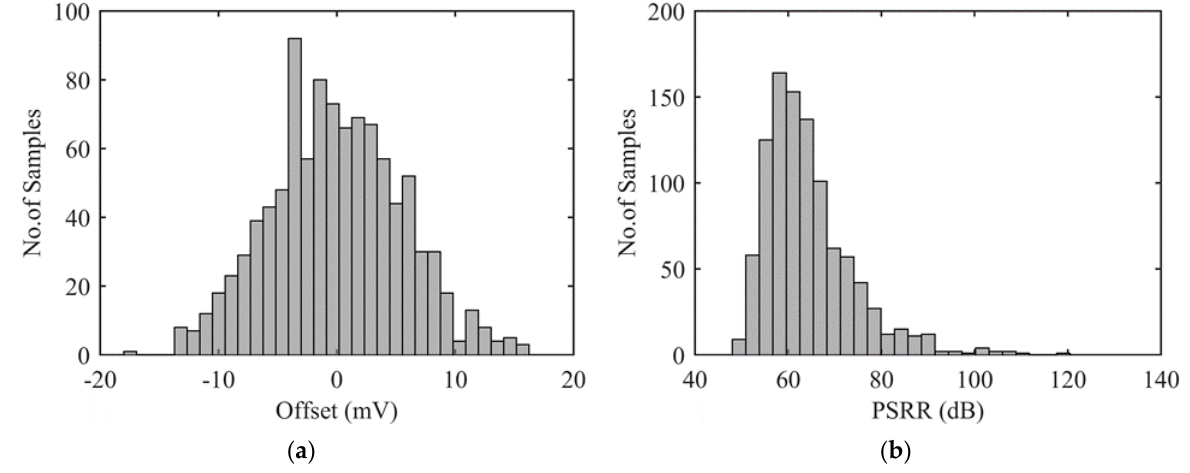
Figure 2. Impact of resistance mismatches on two performances of a Wheatstone bridge: ( a ) Offset in mV and, ( b ) power supply rejection ratio measured at 1 kHz in dB.